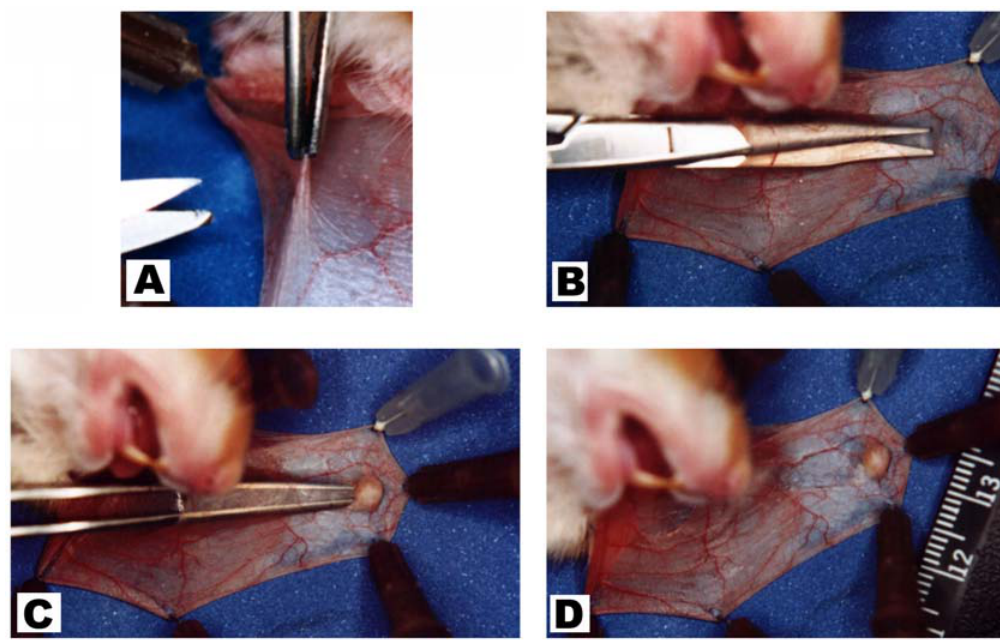
FIGURE 3 – Transplantation operative